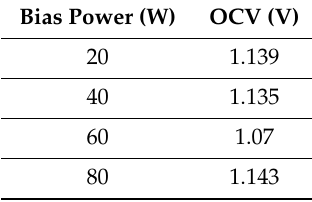
Table 1. Open-circuit voltage (OCV) as a function of the bias power applied on the porte substrate holder. Bias Power